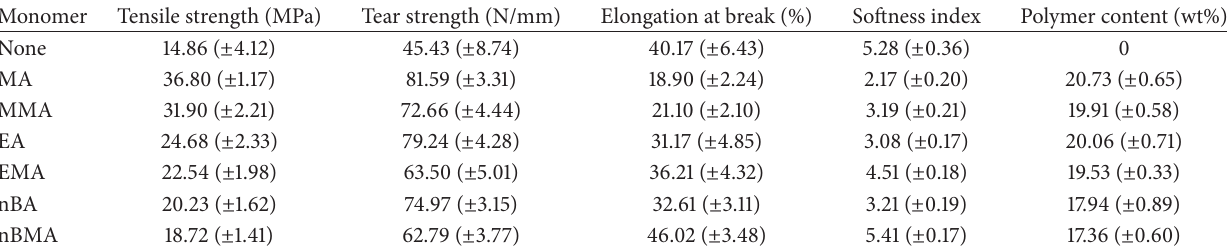
Table 1: Physical properties and polymer contents of the PA/leather split composites.